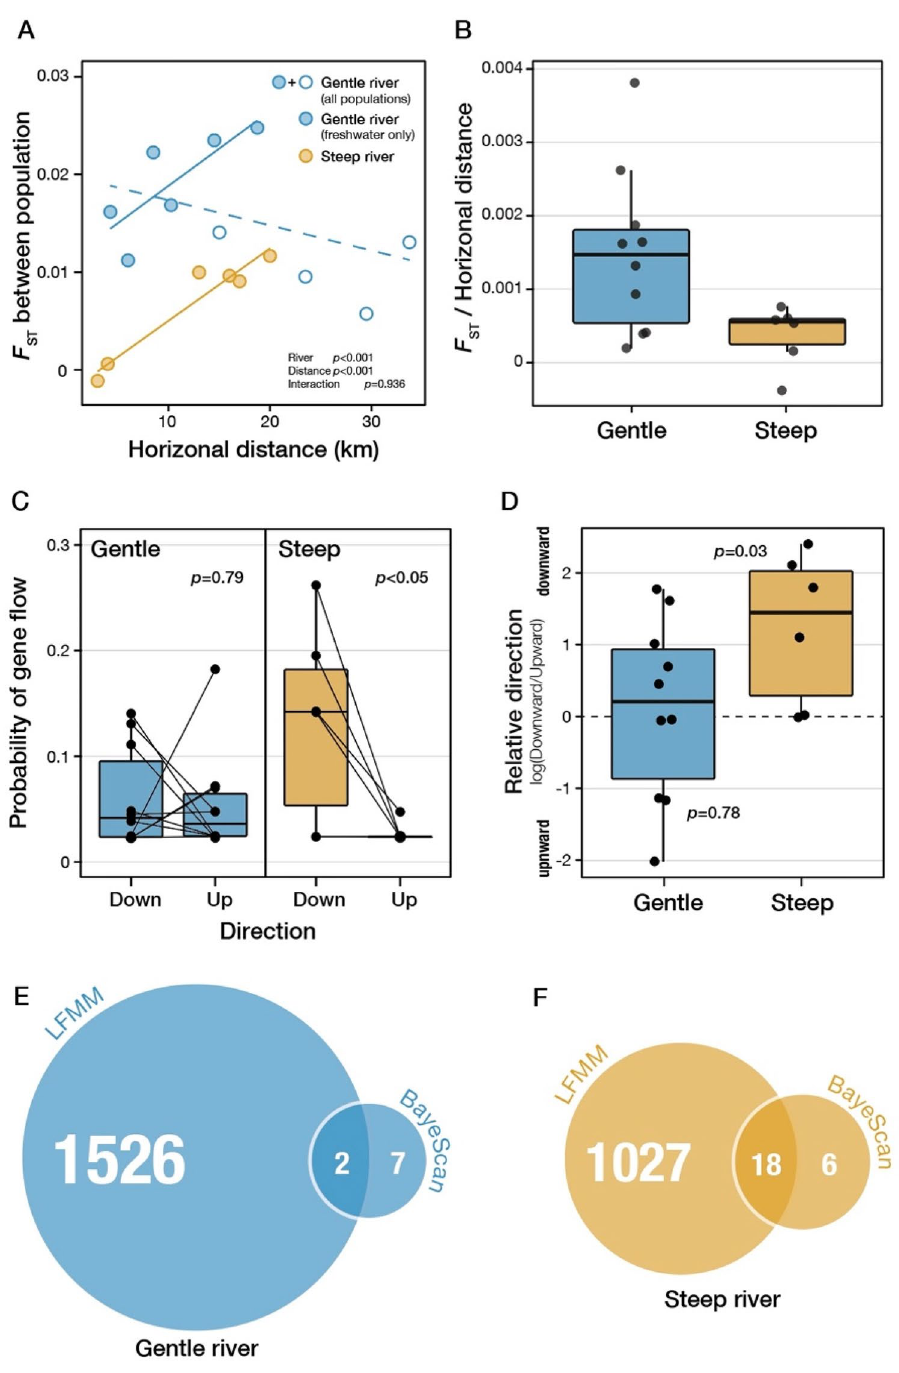
Figure 3. Results of the population genetic analyses. ( A ) The relationship between horizontal distance between populations and the pairwise F ST as genetic differences. Filled circles are values between freshwater populations, and open circles are values between fresh and brackish water populations. P -values based on generalized linear models are shown in the panel, and the blue dashed line represents the regression using all five populations of the gentle river. ( B ) Ratio of F ST to horizontal distance in each river. ( C ) Probability of the downward and upward gene flow between populations in each river. P -values based on paired t-tests are shown in each panel. ( D ) The ratio of downward to upward gene flow. Differences between the upward and downward gene flow in each population were tested by one-sample t-tests, and P -values are shown beside each box. ( E ), ( F ) The number of outlier SNPs detected by LFMM and BayeScan in each